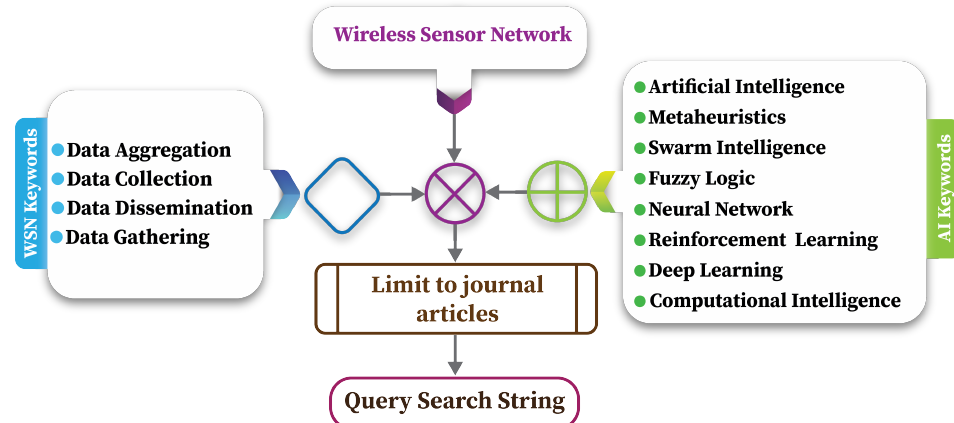
Figure 1. Query search string formation